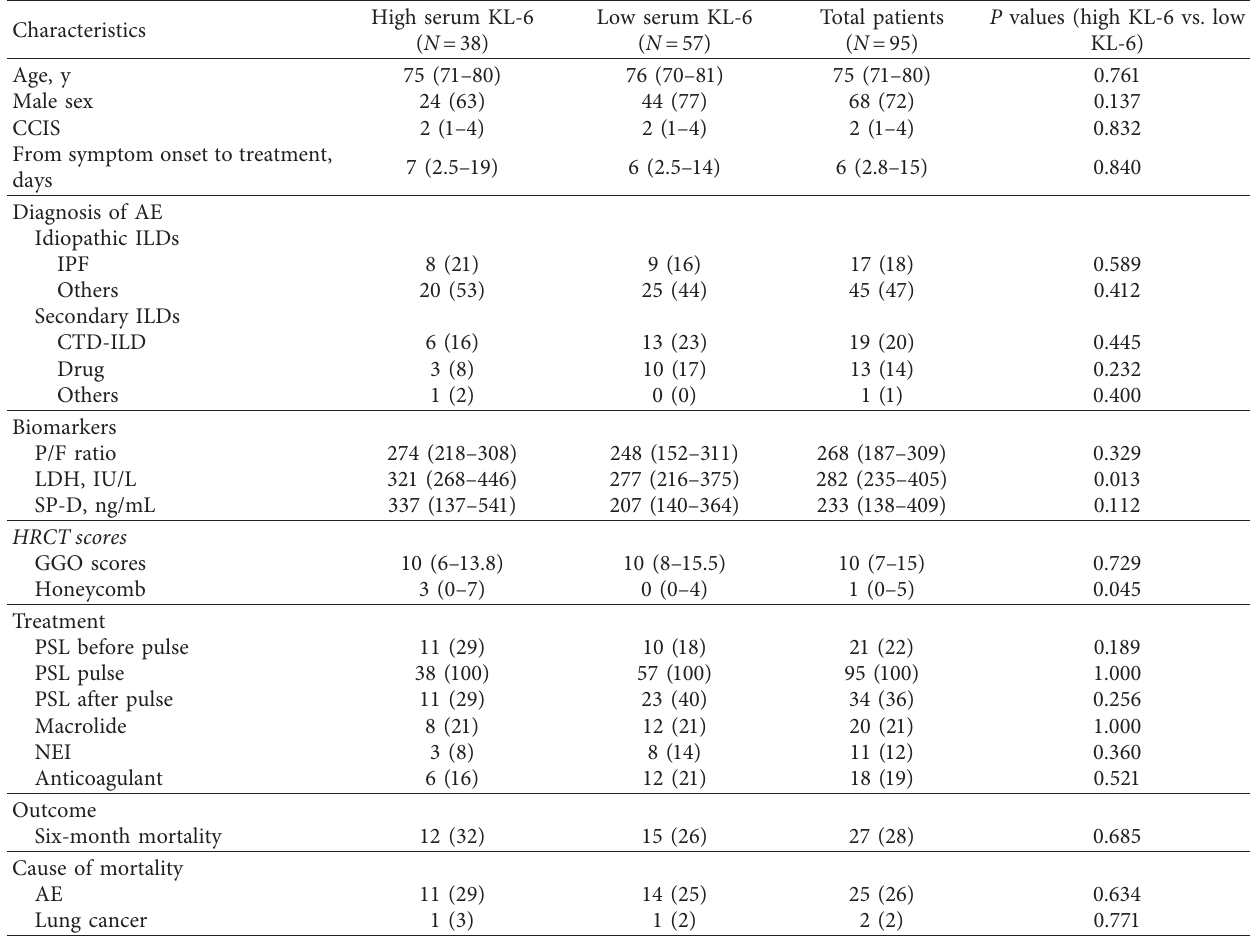
Table 1: Patients’